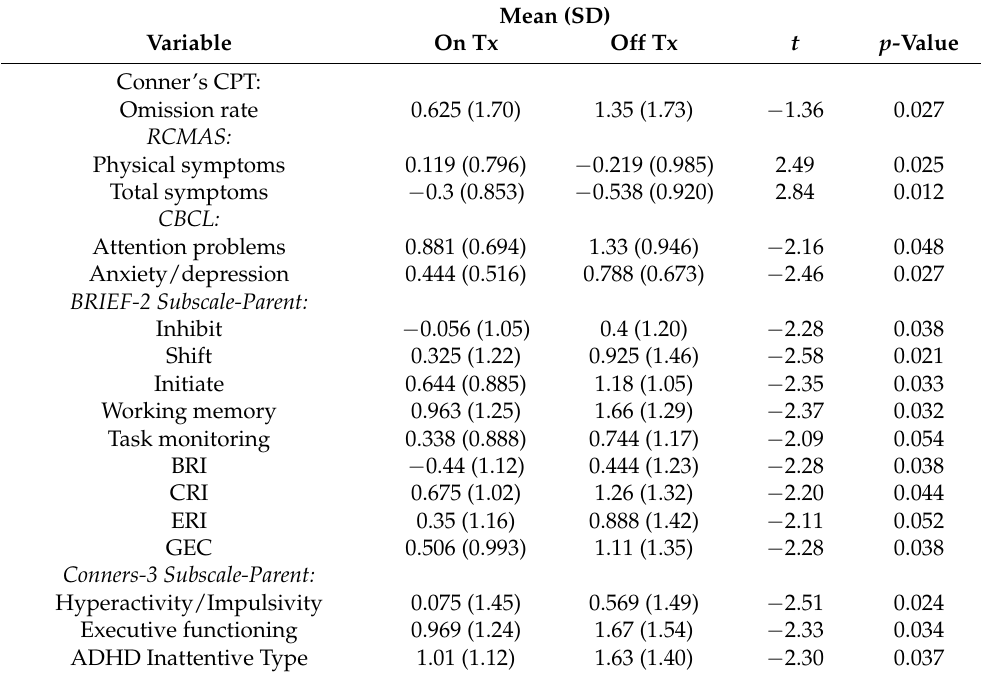
Table 2. Summary of the main treatment